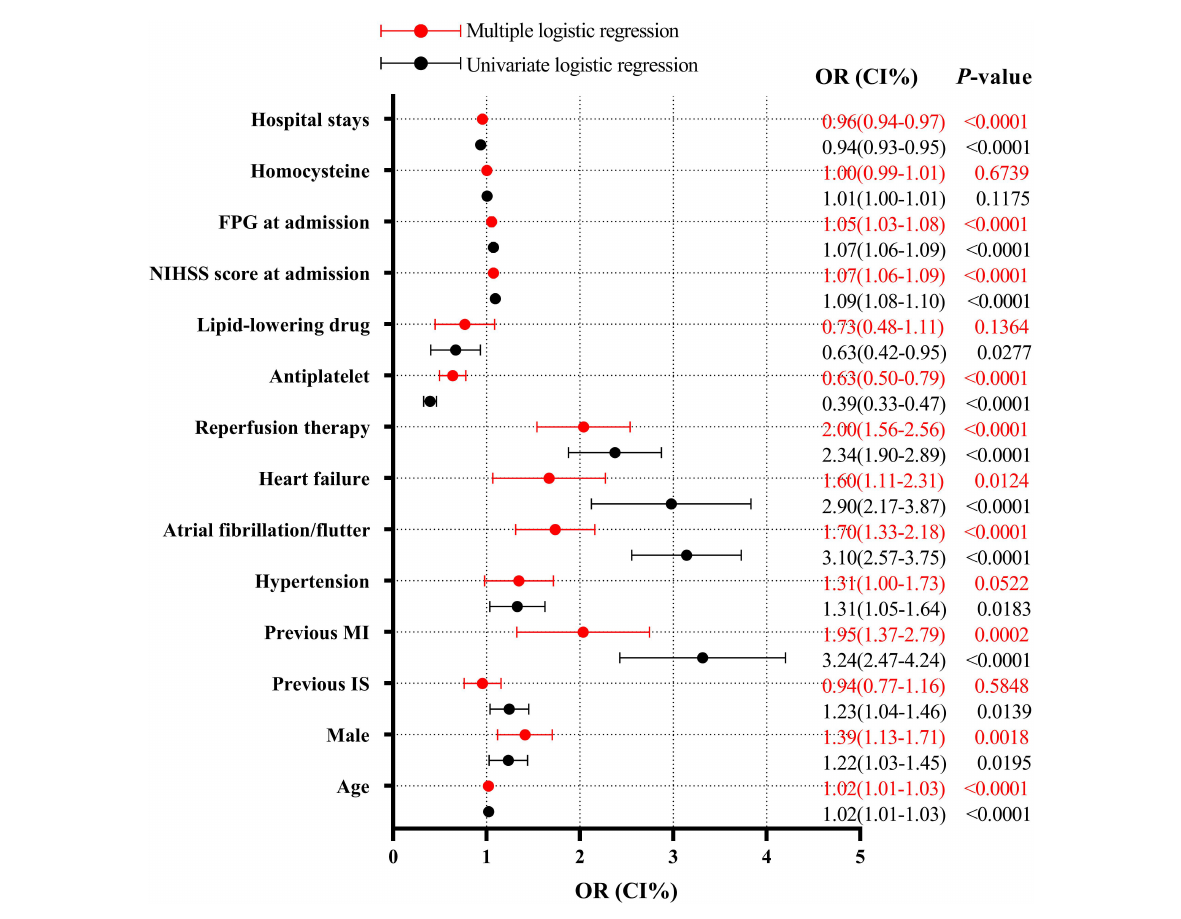
FIGURE2 Logistic regression analysis for mortality after infection. FPG, fasting plasma glucose; NIHSS, National Institutes of Health Stroke Scale; MI, myocardial infarction; IS, ischemic